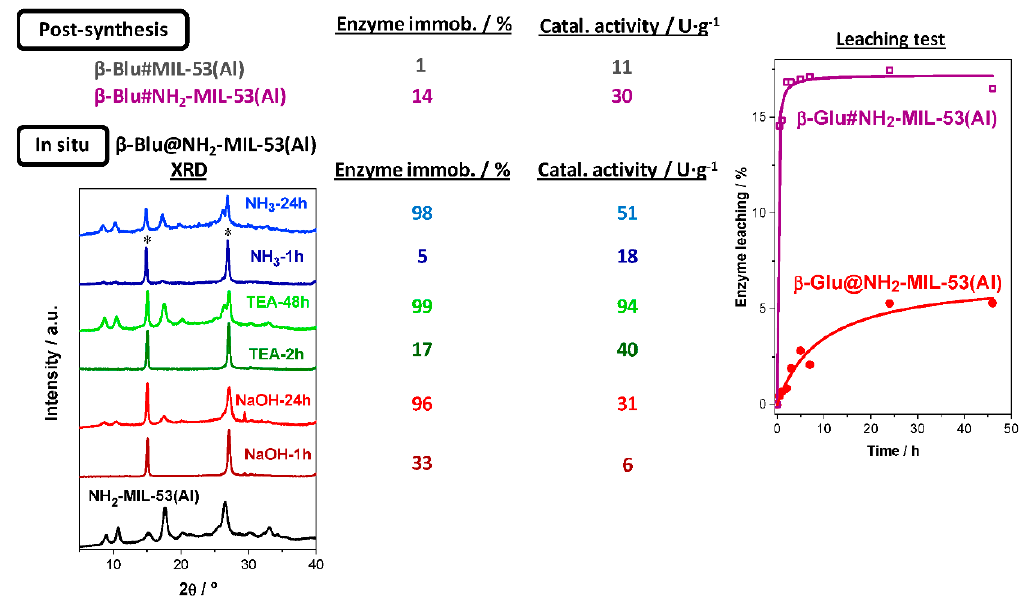
Figure 1. Enzyme immobilization (as a percentage) and catalytic activity (in activity units per g of biocatalyst in the hydrolysis of para -nitrophenyl- β - D -glucopyranoside) for biocatalysts prepared by immobilizing the enzyme beta-glucosidase ( β -Glu) on NH 2 -MIL-53(Al) (and on MIL-53(Al) for a particular case) via post-synthetic and in situ methodologies. The XRD patterns of the in situ prepared biocatalysts β -Glu@NH 2 -MIL-53(Al) using different deprotonating agents (NaOH, TEA and NH 4 OH) are shown (on the bottom left); both asterisks mark the two sharp and intense peaks attributed to H 2 BDC. Kinetics of enzyme leaching for the biocatalysts prepared through post-synthesis ( β -Glu#NH 2 -MIL-53(Al), purple) and in situ ( β -Glu@NH 2 -MIL-53(Al)-NaOH-24, red) methodologies are also plotted (on the right). Data extracted from [36].